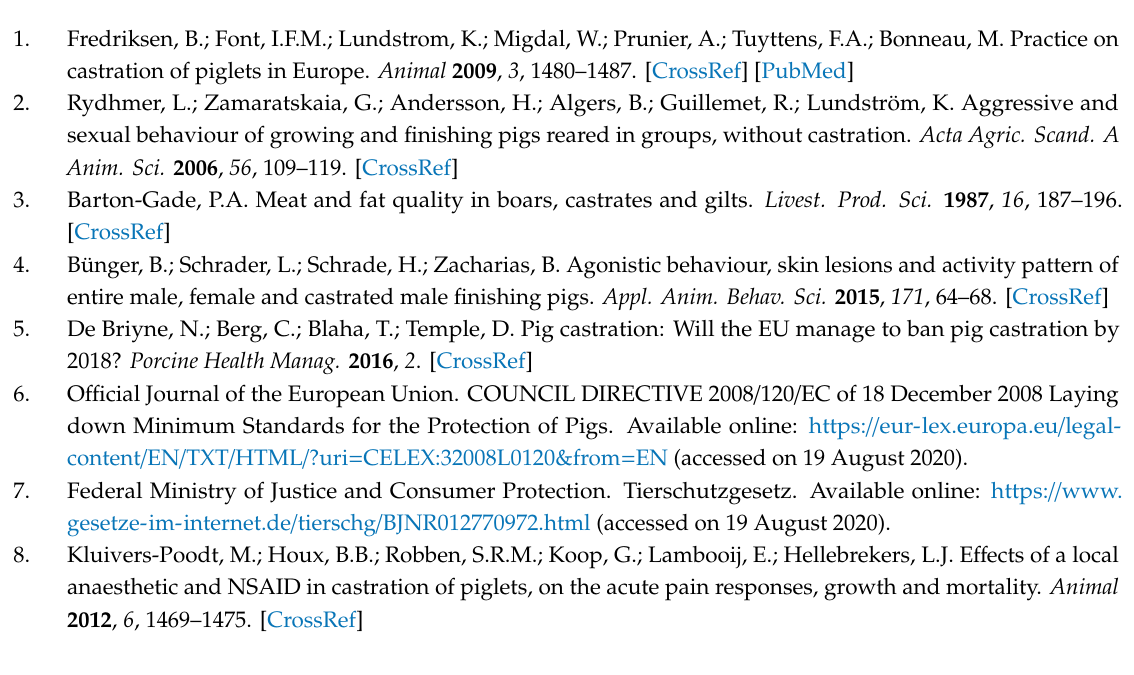
Table S1: Score used to evaluate the defensive movements according to Leidig et al. [10] during injection, skin incision and severing of the spermatic cord; Table S2: Score used to evaluate the castration wounds according to Zankl [29]; Table S3: Score used to evaluate the postoperative bleeding according to Enz et al.